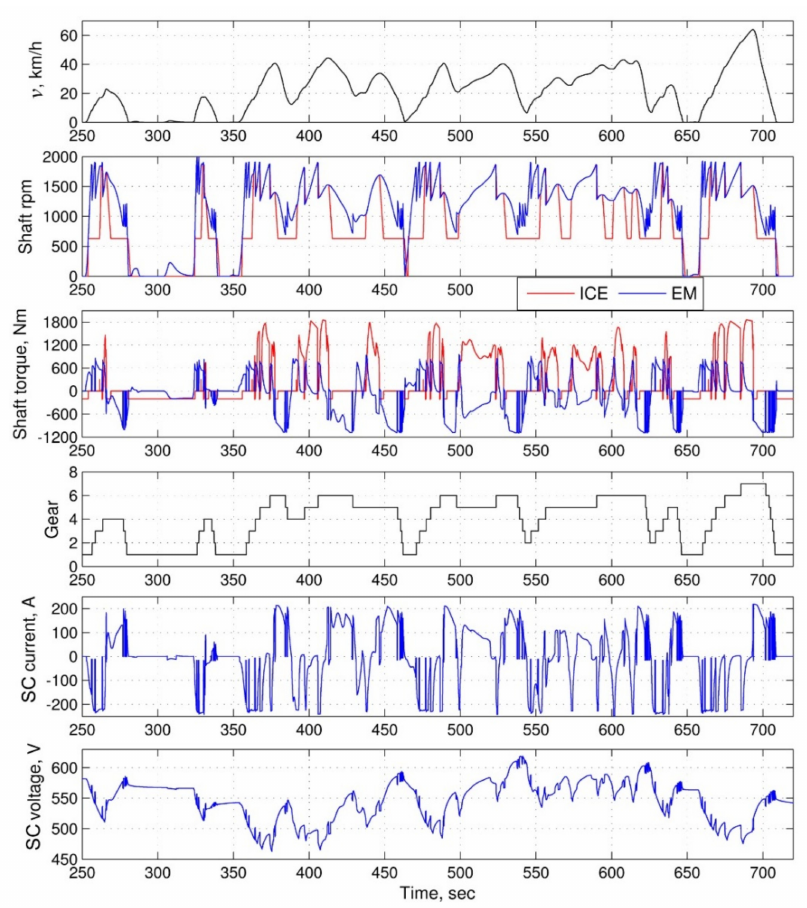
Figure 12. Hybrid powertrain operating variables calculated in the World Harmonized Vehicle Cycle (WHVC)